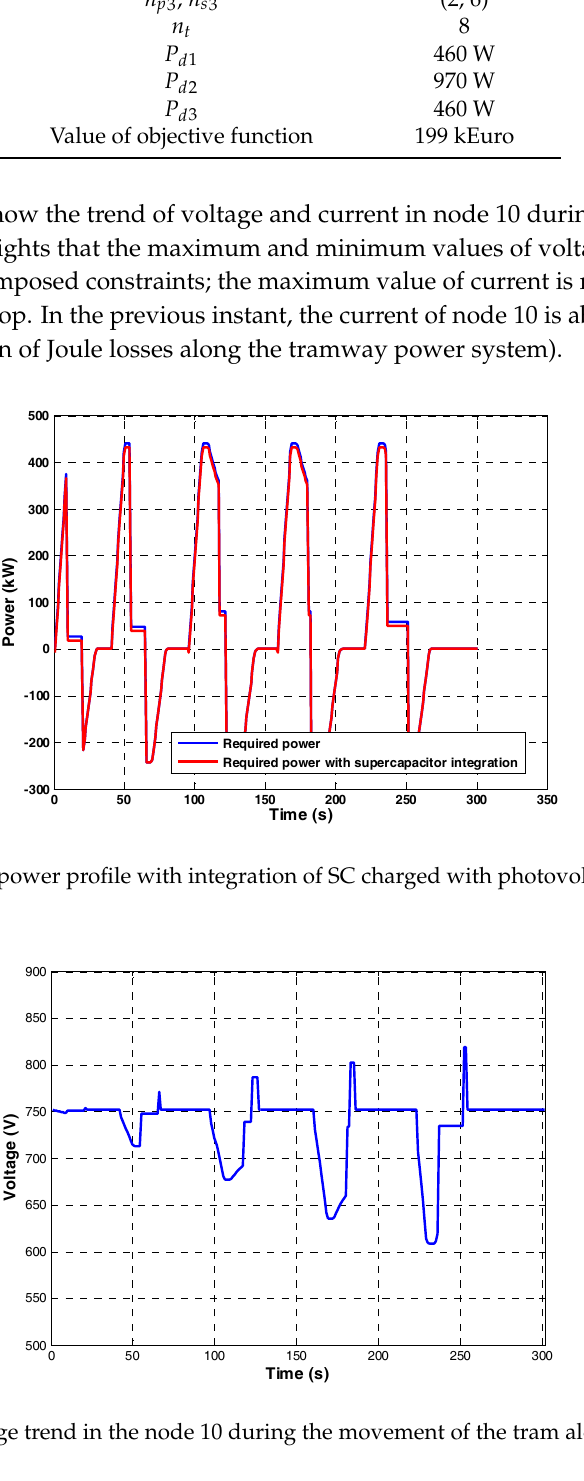
Figure 11. Voltage trend in the node 10 during the movement of the tram along the track.